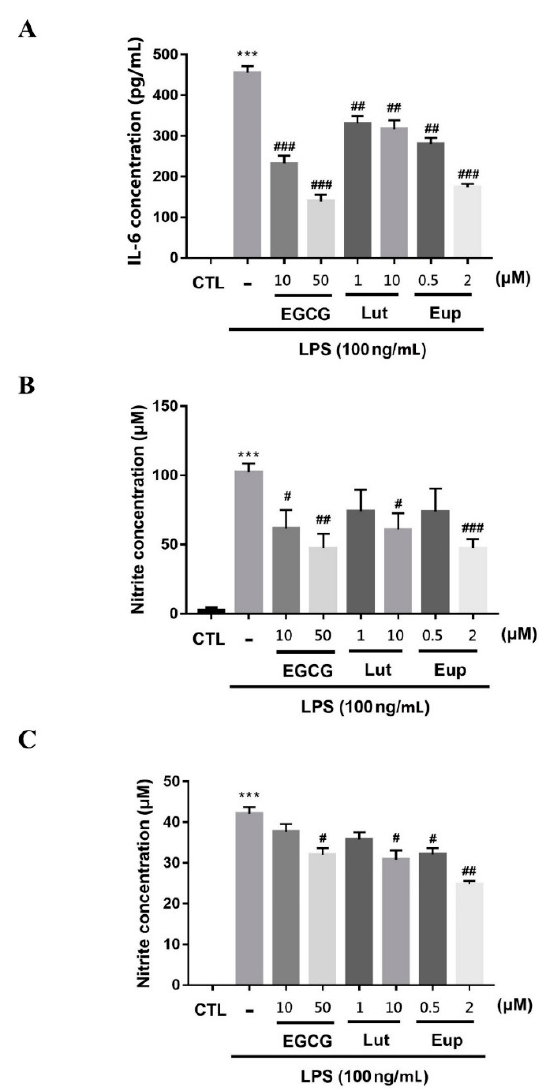
Figure 3. Eupatin’s ability to inhibit LPS-induced production of IL-6 and nitric oxide. After 30-min incubation of ( A , B ) RAW264.7 and ( C ) BV-2 cells with the indicated concentrations of EGCG, luteolin, or eupatin, the cells were stimulated for 24 h using 100 ng / mL LPSs. The supernatants were subsequently collected and assayed for IL-6 and nitrite. The results are presented as the mean ± standard error of the mean of three independent experiments. *** p < 0.001 for comparisons with the control group; # p < 0.05, ## p < 0.01, and ### p < 0.001 for comparisons with the LPS-treated group.